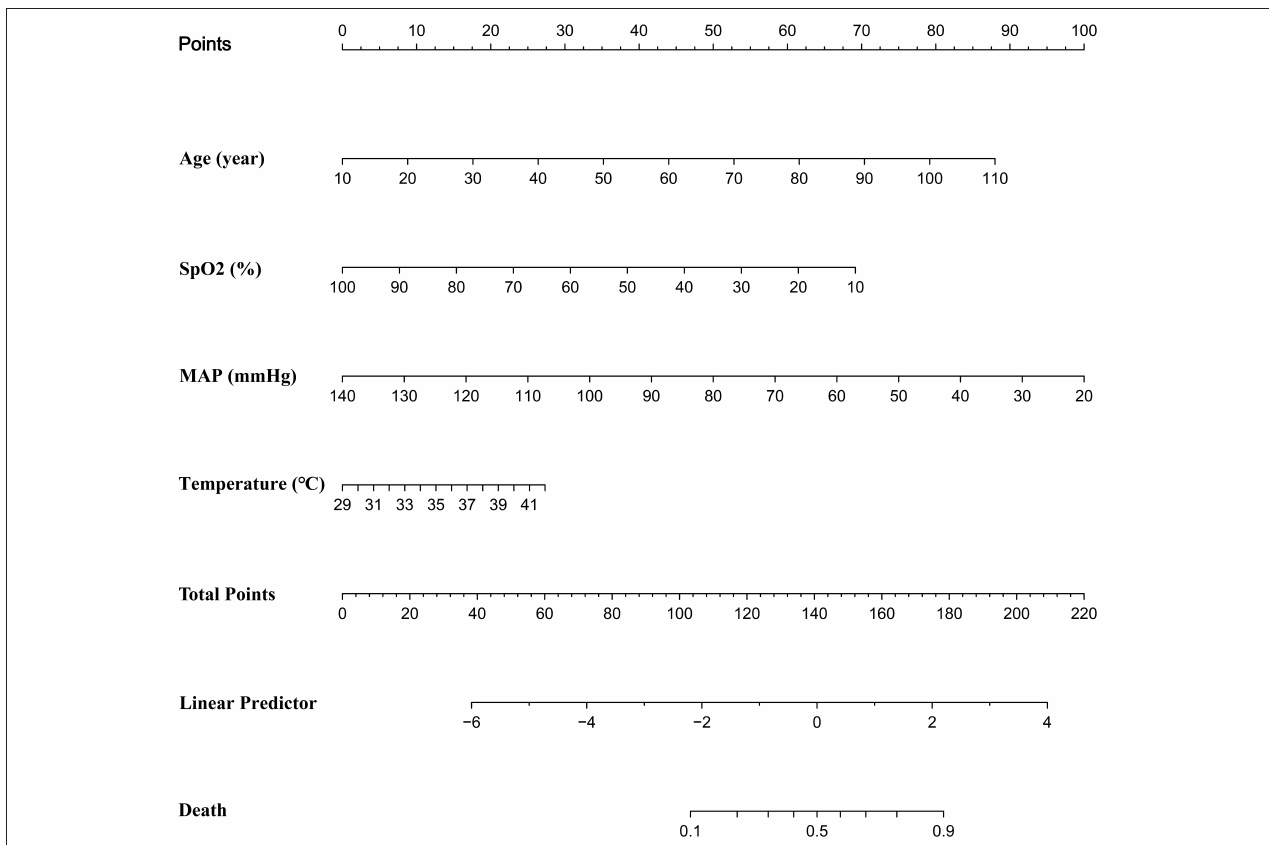
FIGURE 3 | The calibration curve of the full model in training cohort and validation